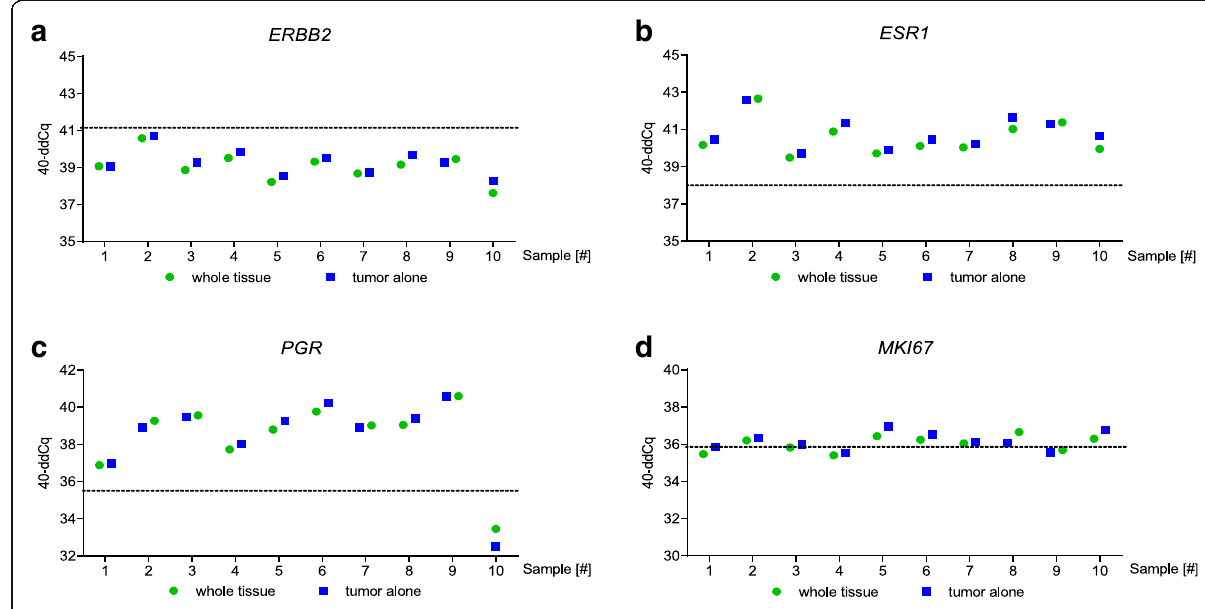
Fig. 2 Effect of adipose tissue on relative gene expression. Shown in the graph are gene expression data of n = 10 breast cancer specimen for ERBB2 ( a ), ESR1 ( b ), PGR ( c ) and MKI67 ( d ) in whole sections (over 50% adipose tissue content, green circles) versus tumor-enriched sections (blue squares). Dotted lines represent the respective cut-off for the four marker genes ( ERBB2 : 41.10; ESR1 : 38.00; PGR : 35.50; MKI67 :